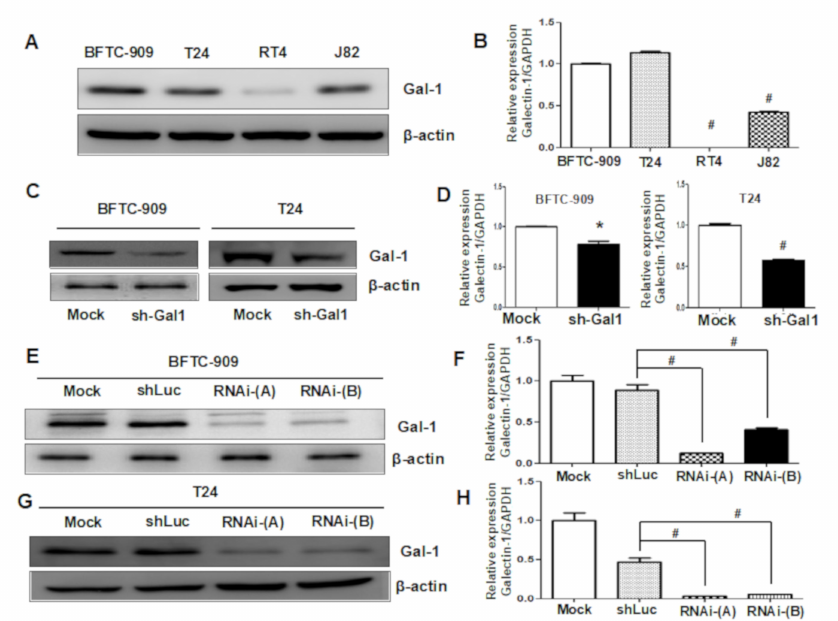
Figure 3. Evaluation of GAL1 expression in UC cell lines and verification of downregulation e ffi ciency through Western blotting and q-PCR analyses: Data are presented as mean ± standard error of the mean from three independent experiments. ( A,B ) High expression of GAL1 in the BFTC-909 and T24 cell lines and low GAL1 expression in the J82 and T24 cell lines were observed. ( C,D ) The e ffi ciency of GAL1 knockdown by using shRNA in the BFTC-909 and T24 cell lines was assessed through Western blotting and q-PCR analyses. ( E,F ) The e ffi ciency of GAL1 knockdown by using lentiviruses was assessed through Western blotting and q-PCR analyses in the BFTC-909 cell line. ( G,H ) The e ffi ciency of GAL1 knockdown by using lentiviruses was assessed through Western blotting and q-PCR analyses in the T24 cell line. * p < 0.05, # p <